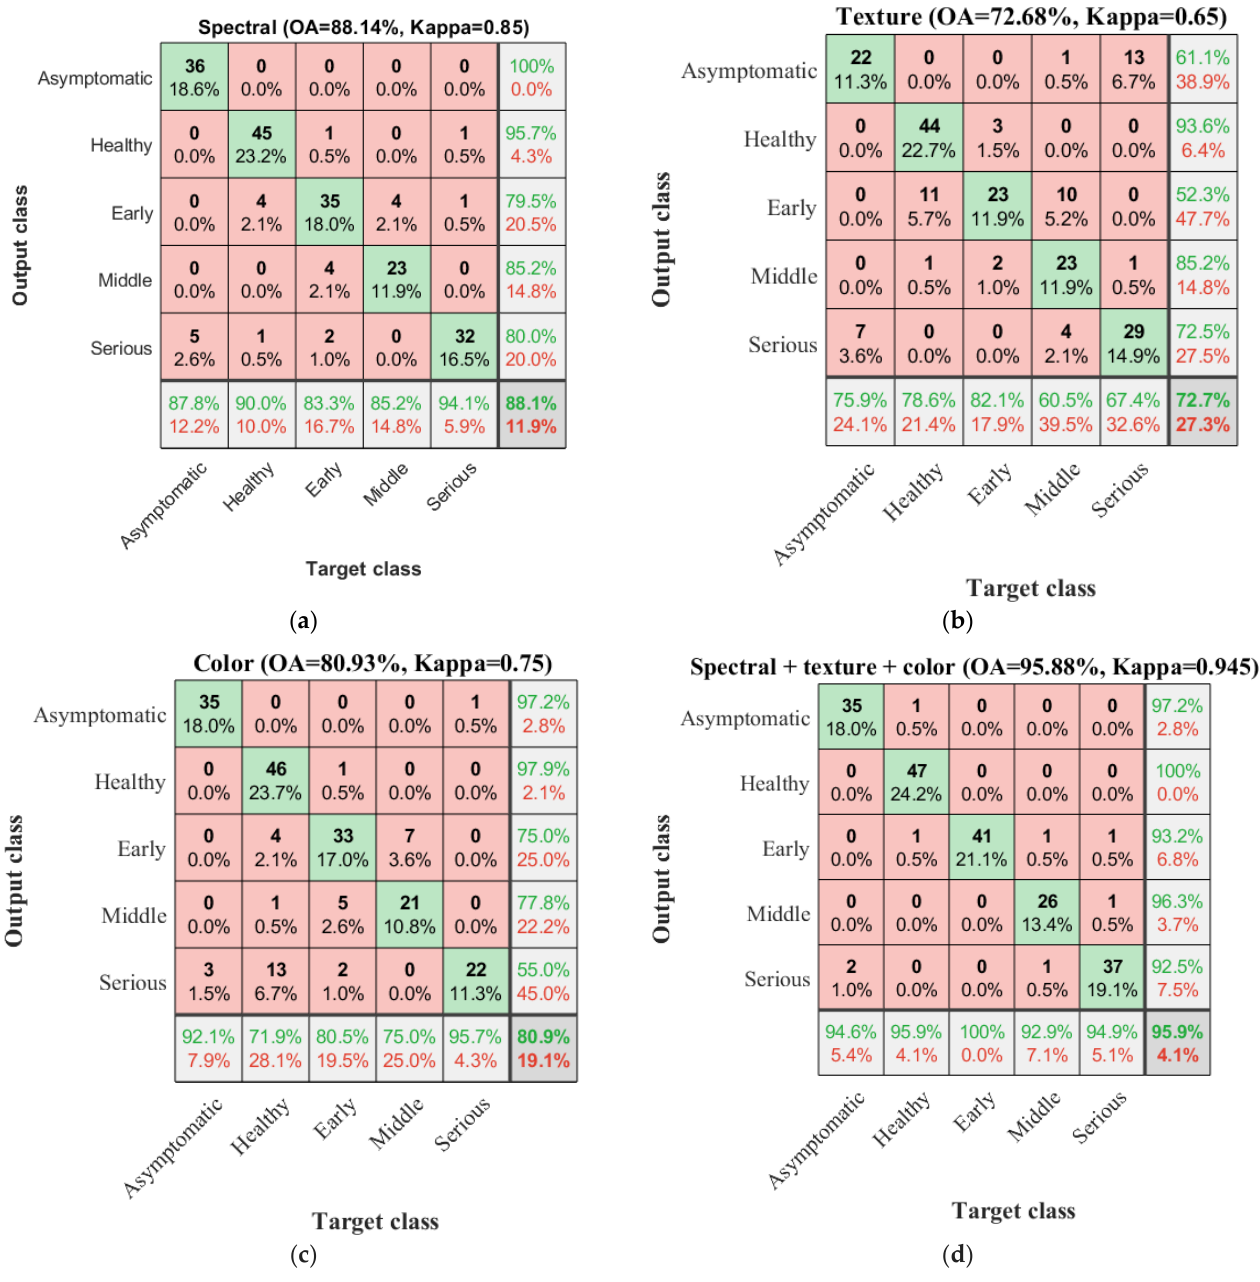
Figure 7. Confusion matrix of rubber tree powdery mildew with different feature combinations based on the SVM model. ( a ) Spectral features, ( b ) texture features, ( c ) color features, ( d ) spectral + texture + color.